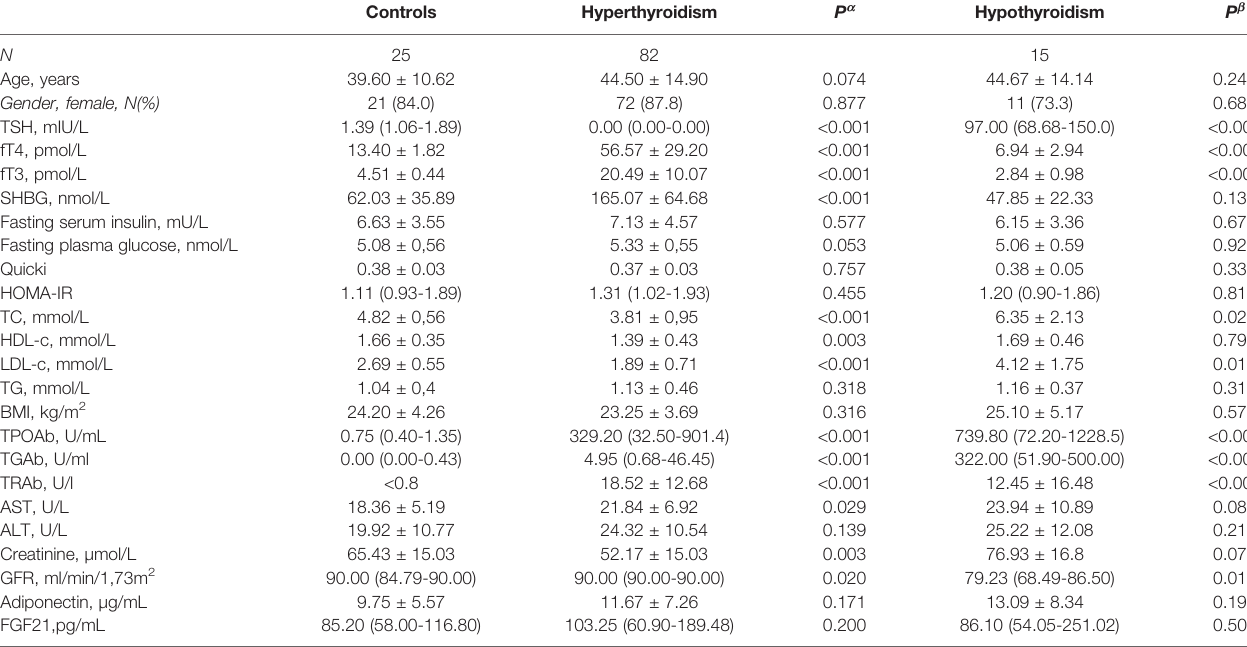
TABLE 1 | Serum FGF21 and biochemical parameters in the study groups and